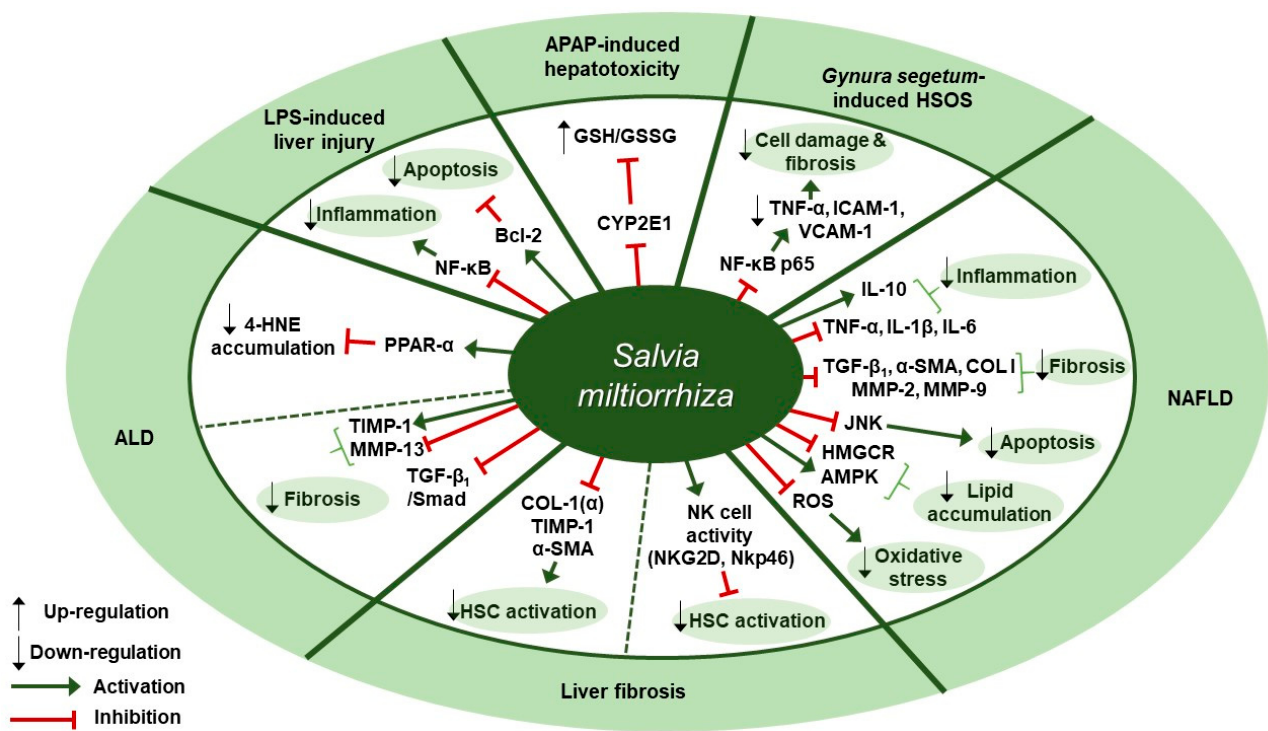
Figure 3. Therapeutic targets of S. miltiorrhiza in liver diseases. ALD, alcoholic liver disease; LPS, lipopolysaccharide; APAP, acetaminophen; HSOS, hepatic sinusoidal obstruction syndrome; NAFLD, non-alcoholic fatty liver disease; CYP2E1, cytochrome P450 2E; GSH/GSSG ratio, glutathione/glutathione disulfide ratio; NF- κ B, nuclear factor kappa-light-chain-enhancer of activated B cells; TNF- α , tumor necrosis factor- α ; ICAM-1, intercellular adhesion molecule-1; VCAM-1, vascular cell adhesion molecule 1; IL-10, interleukin 10; IL-1 β , interleukin 1 beta; IL-6, interleukin -6; TGF- β 1, transforming growth factor beta 1; α -SMA, alpha-smooth muscle actin; COL I, type I collagen; MMP, matrix metalloproteinase; JNK, c-Jun N-terminal kinase; HMGCR, 3-hydroxy-3-methyl-glutaryl-coenzyme A reductase; AMPK, AMP-activated protein kinase; ROS, reactive oxygen species; NKG2D, natural killer group 2D; NKp46, natural killer p46; HSC, hepatic stellate cell; TIMP-1, tissue inhibitor of metalloproteinase-1; PPAR- α , peroxisome proliferator-activated receptor alpha; 4-HNE, 4-hydroxynonenal; Bcl-2, B-cell lymphoma 2.